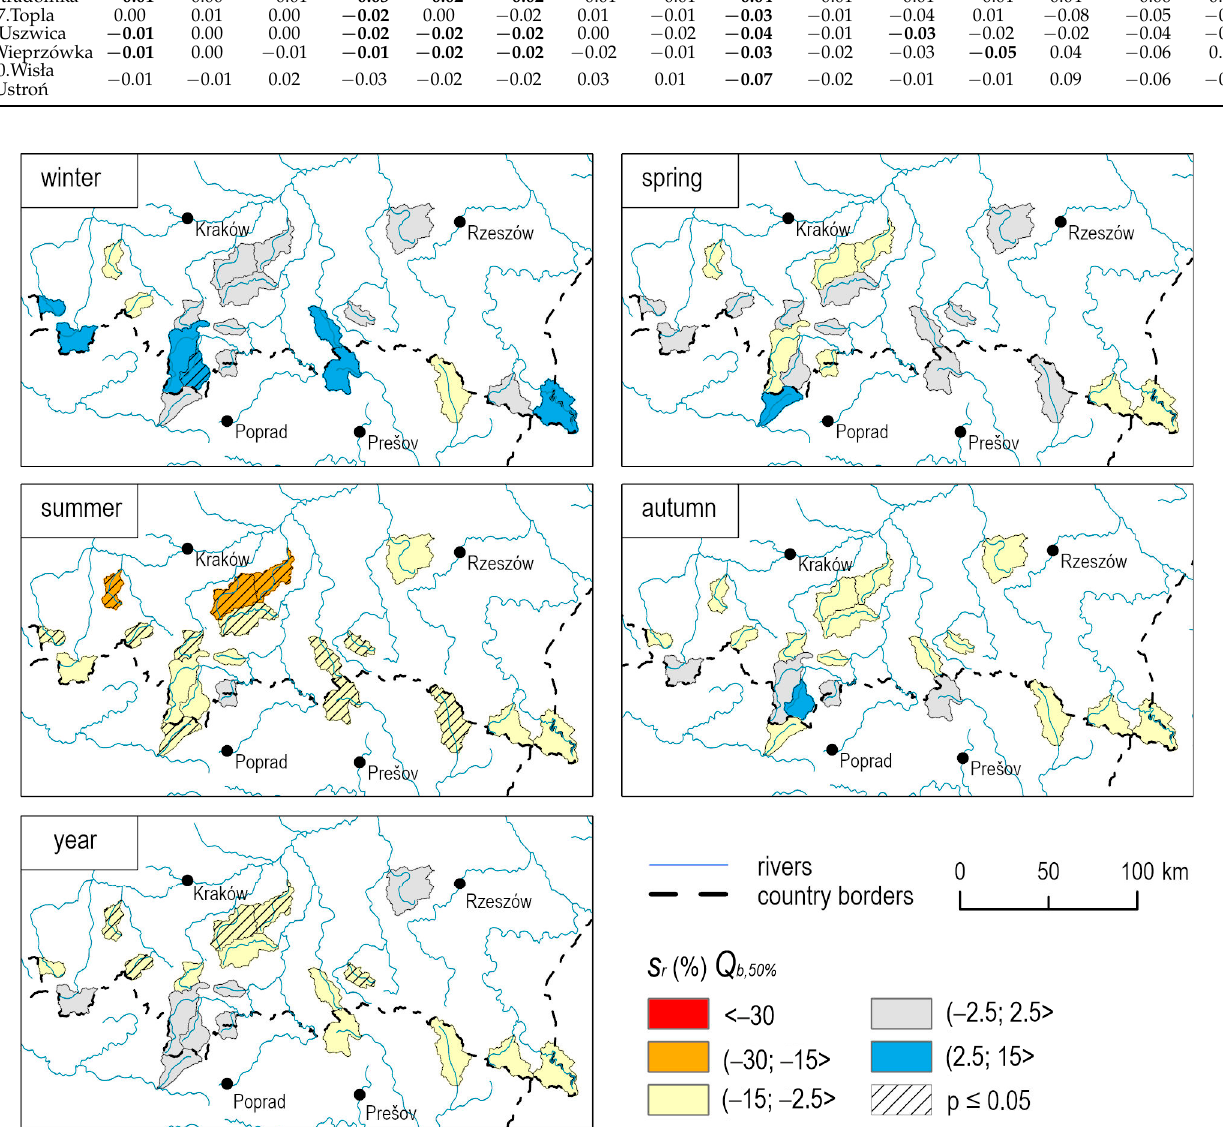
Figure 5. Relative change in the annual median value of daily baseflow ( Q b, 50% ) in the years 1970–2019. Table 3. Theil–Sen estimator (mm/10 years) for daily baseflow ( Q b ) percentiles obtained for the entire year (Yr), winter (W), spring (SP), summer (SU), and autumn (A); statistically significant trends are marked in bold.